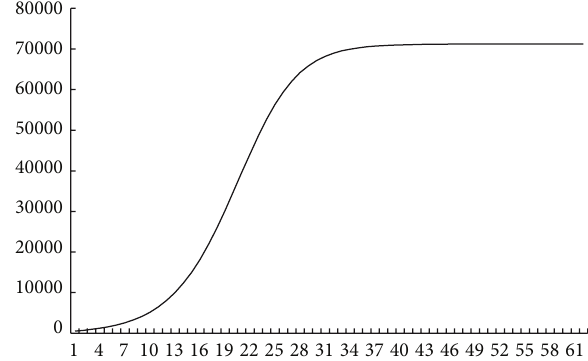
Figure 10: Plot of the diffusion curve of telephone in China governed by model (71).